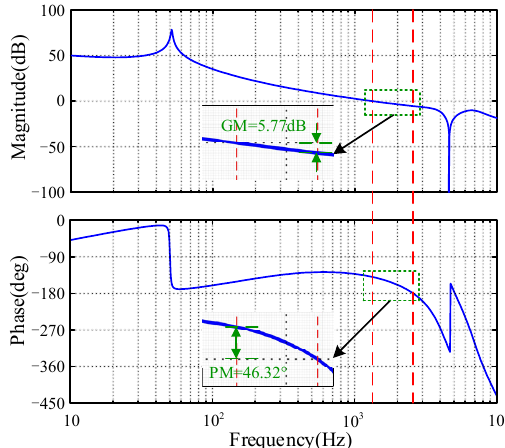
Figure 6. Bode diagram of the improved indirect current control method characteristic diagram.